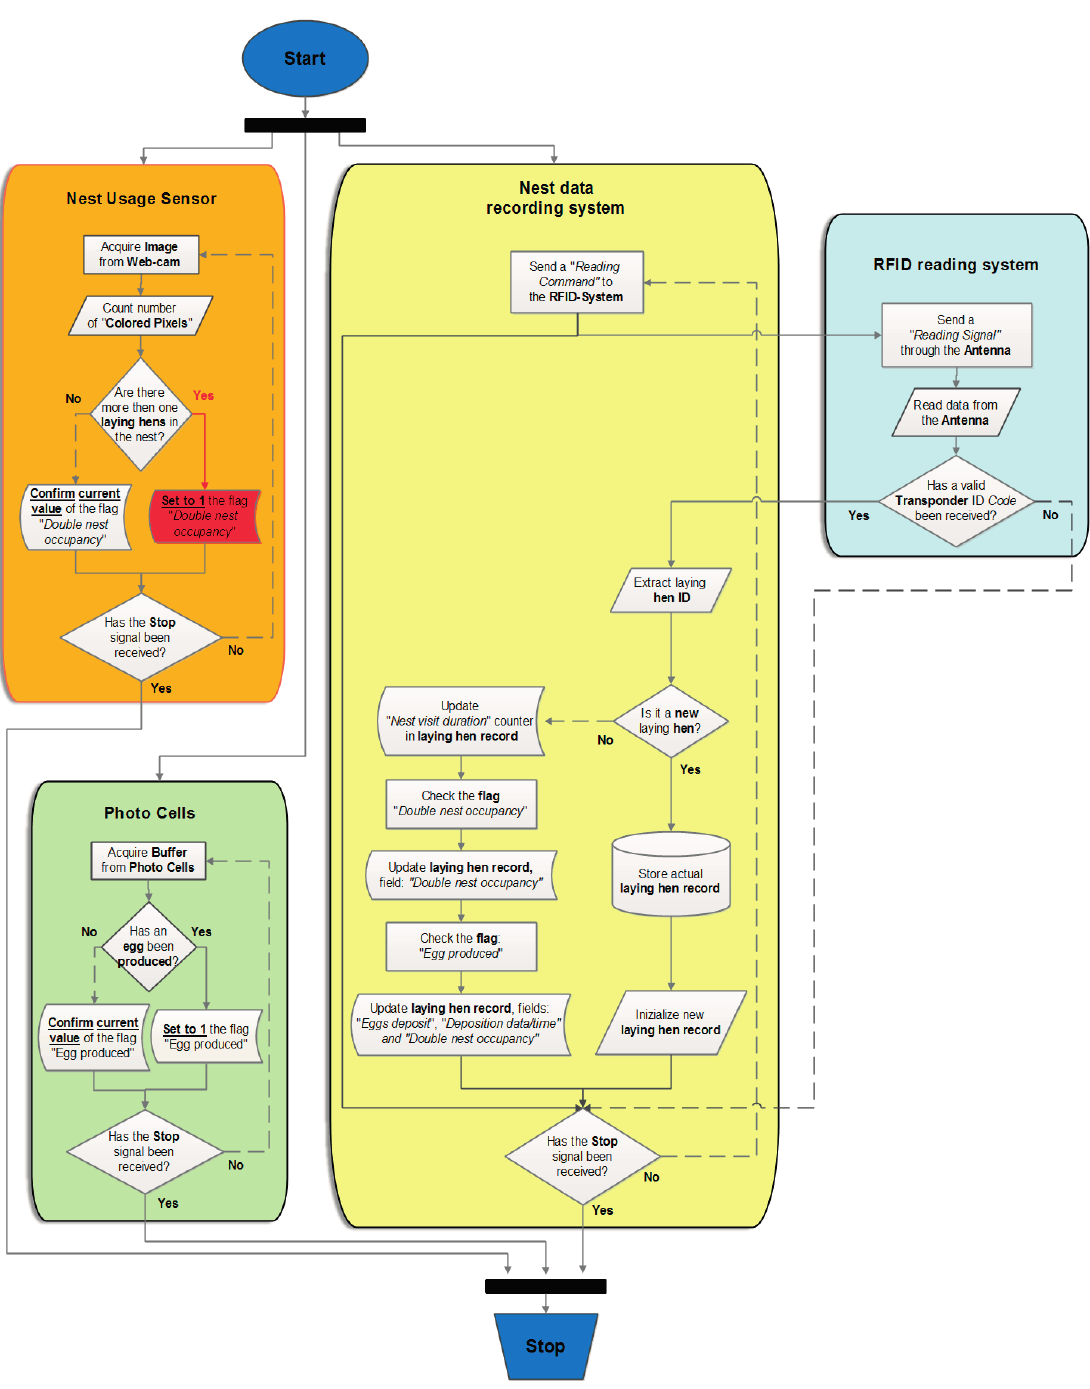
Figure 1. Application software flow diagram. The pathway in the case that a double nest occupation is detected is highlighted in